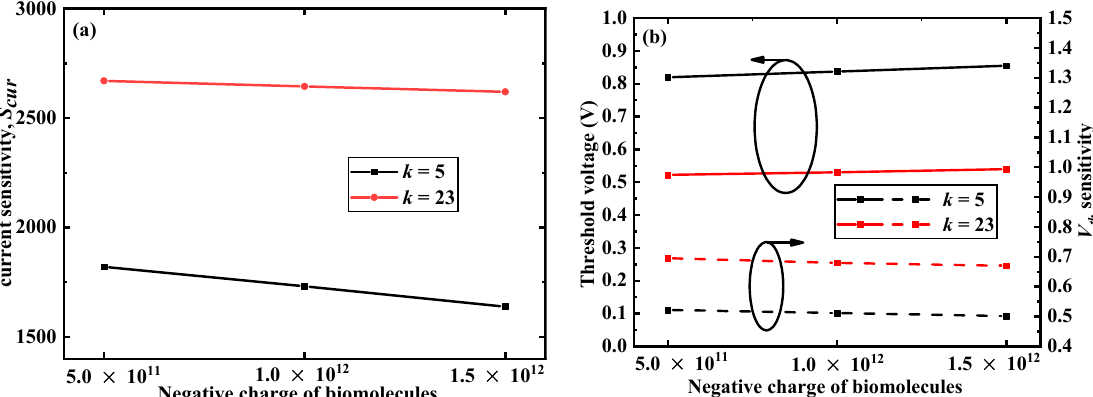
Figure 8. ( a ) Effect of different negative charge of biomolecules on current sensitivity and ( b ) V th and S Vth of the DM-LTFET at V g = 1 V, V d = 0.5 V, k = 5 and 23, and T c = 5 nm.